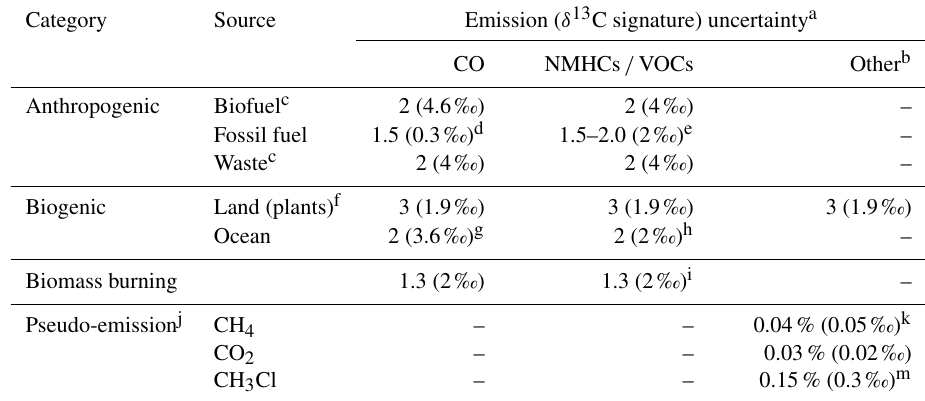
Table 6. Uncertainties associated with emission sources and isotopic